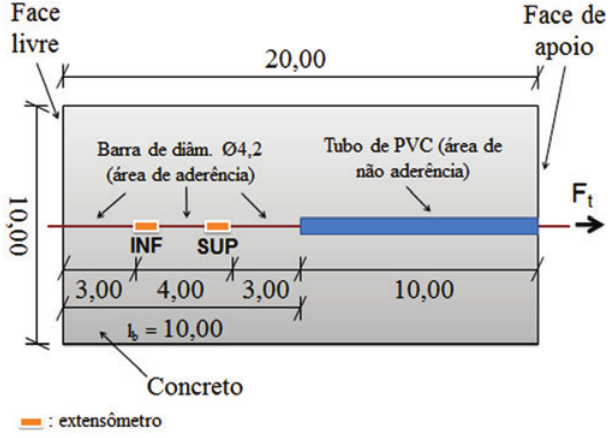
CP tipo "Barra" com extensômetros (corte longitudinal)